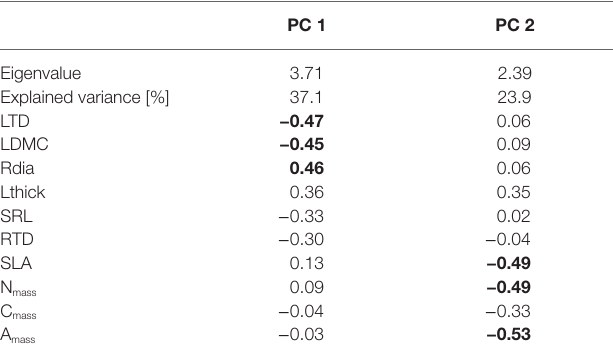
TABLE 2 | Trait loadings on the first two principal components (PC) of a principal component analysis (PCA) with ten resource-use related traits in 30 winter annual species (see Figure 1 ).